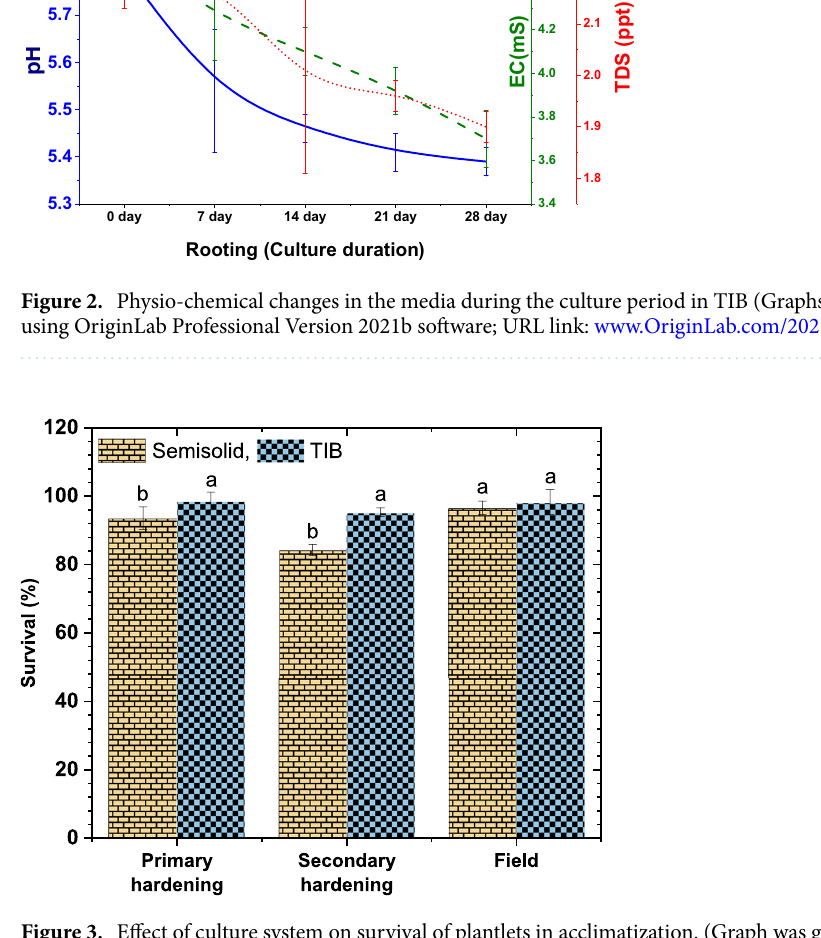
Figure 3. Effect of culture system on survival of plantlets in acclimatization. (Graph was generated using OriginLab Professional Version 2021b software; URL link: www. Origi nLab. com/